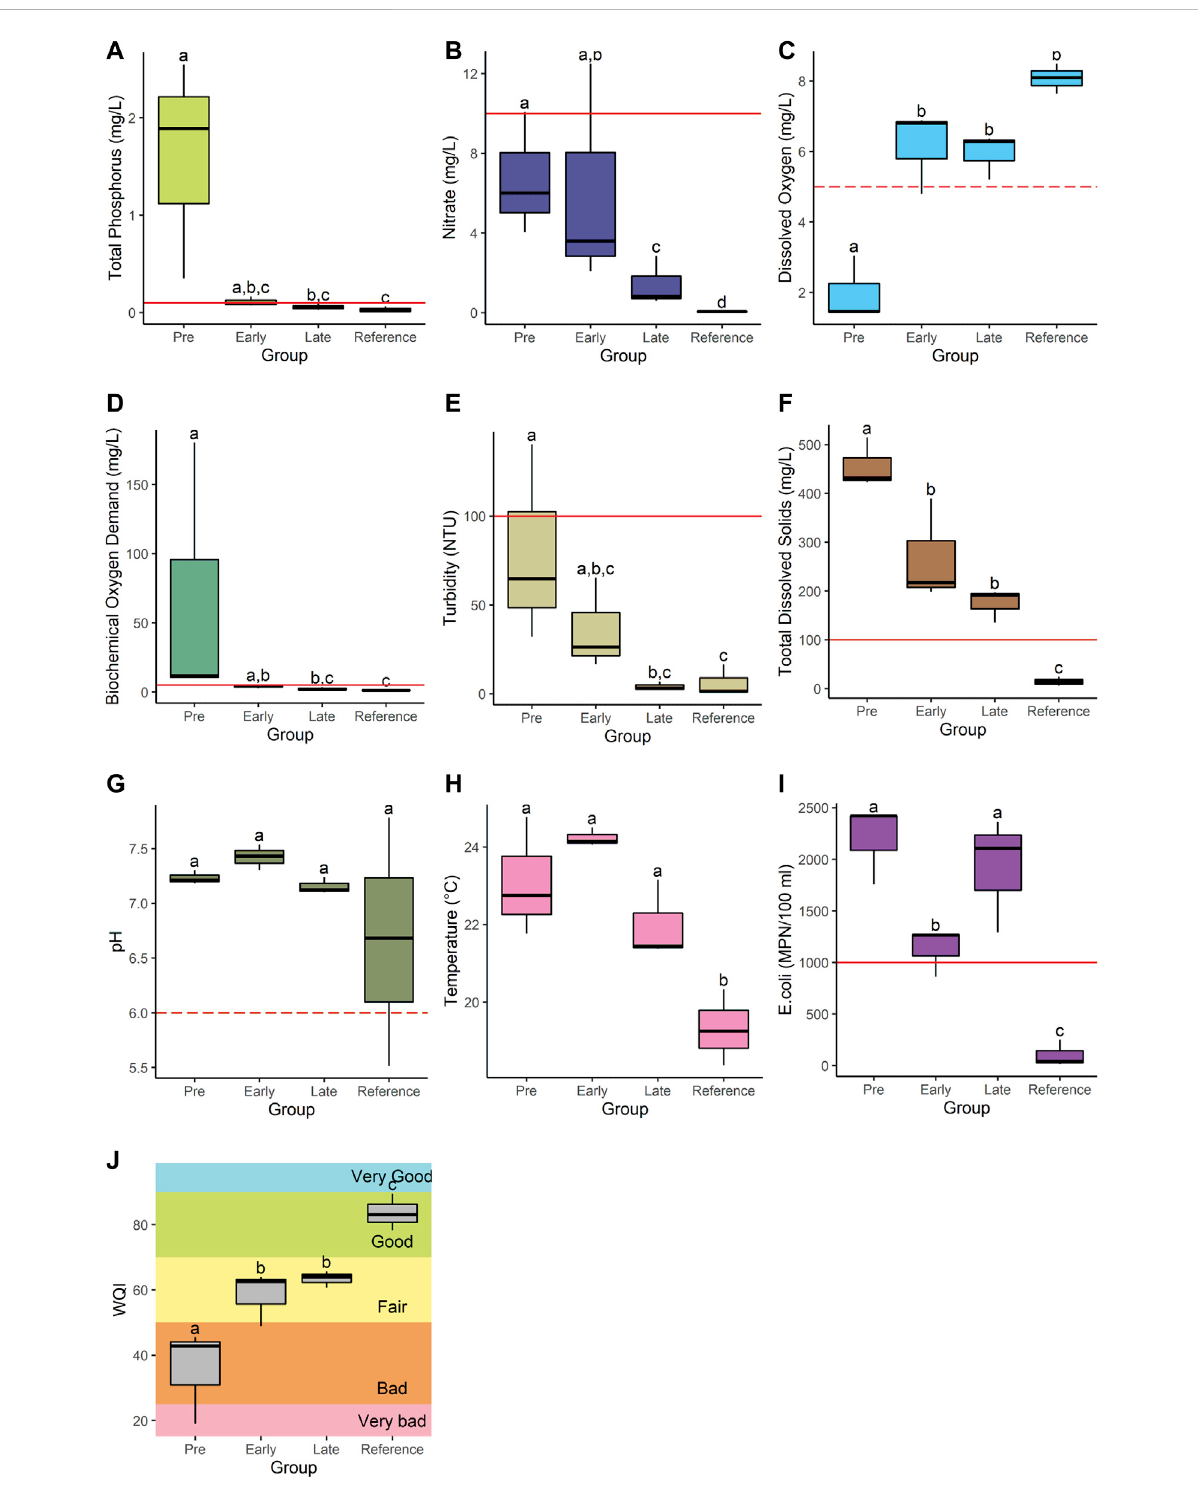
FIGURE 4 Differences in water quality at pre-rehabilitation, early post-rehabilitation, later post-rehabilitation, and reference sites: (A) Total phosphorus; (B) Nitrate; (C) Dissolved Oxygen; (D) Biochemical Oxygen Demand; (E) Turbidity; (F) Total Dissolved Solids; (G) pH; (H) Water temperature; (I) Escherichiacoli and (J) WaterQualityIndex.Thecontinuousredlinesrepresentlegalupperlimitsanddashedredlines,thelowerlegallimitsforwater class